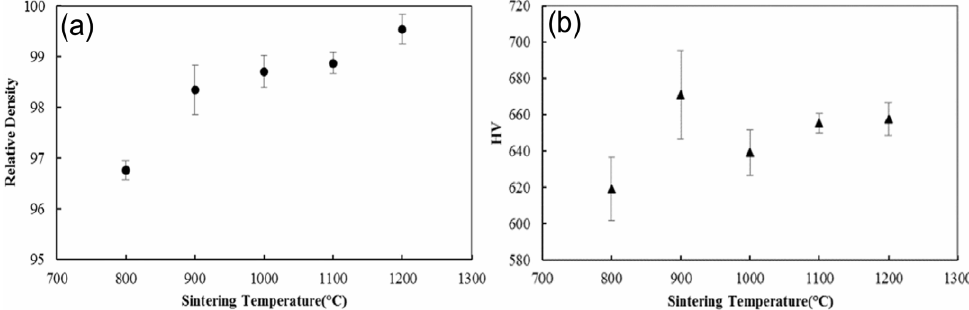
Figure 1. Spark plasma-sintered Ti–20Nb–13Zr at different temperatures: ( a ) relative density and ( b ) hardness. (Reproduced with permission from ref. [140]. Copyright (2015), Elsevier).